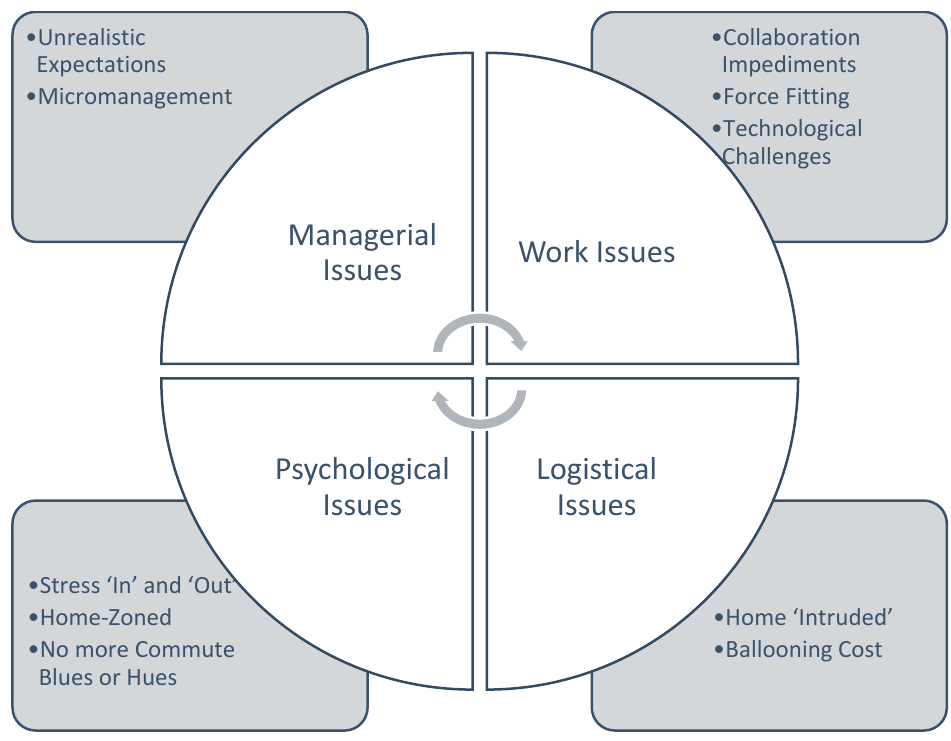
Figure 1. Work ‐ Life Integration and Conflict—Issues due to pandemic ‐ imposed work arrange ‐ Figure 1. Work-Life Integration and Conflict—Issues due to pandemic-imposed work ments.